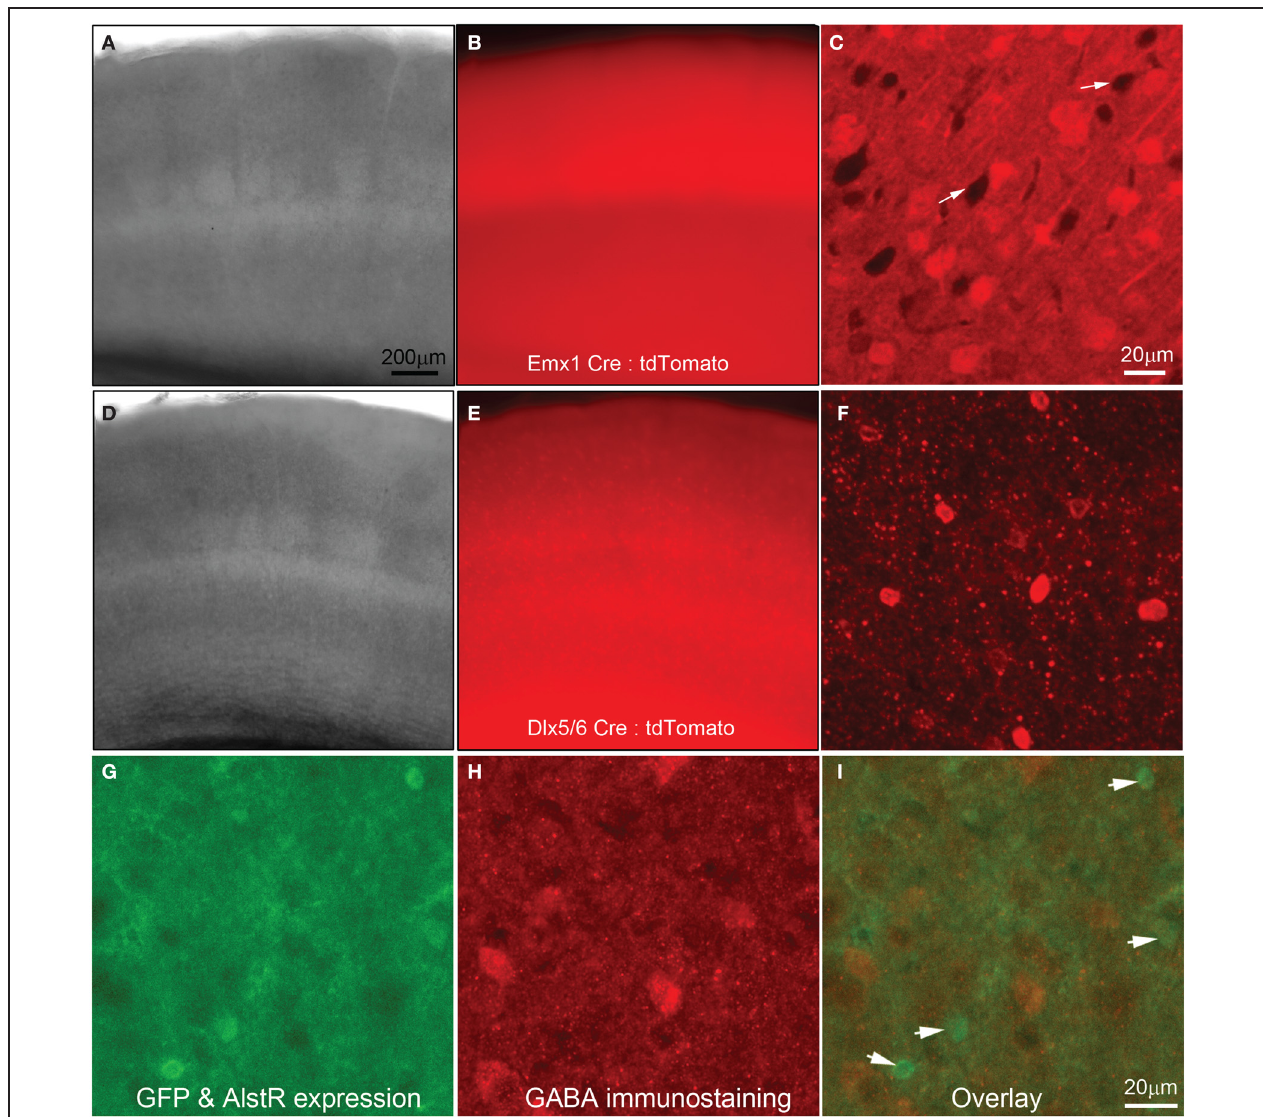
exposure times for Emx1-Cre: tdTomato and Dlx5/6-Cre: tdTomato fluorescent images were at an order of difference due to an extremely high-level of fluorescence in Emx1-Cre: tdTomato slices. (F) Confocal microscopy of tdTomato-expressing neurons (presumptive inhibitory neurons) under higher magnification. Note the morphological differences of tdTomato-expressing cells in (C) and (F) . (G–I) AlstR-expressing neurons, resulting from crossing of the Emx1-Cre mouse line to the AlstR mouse line, are not immunopositive for GABA. In (G) , the AlstR-expressing neurons also express GFP. (H) is the same field of view of the slice with GABA immunostaining. (I) The overlay of the (G) and (H) , with the arrowheads pointing to the GFP-AlstR-expressing neurons that are not GABA